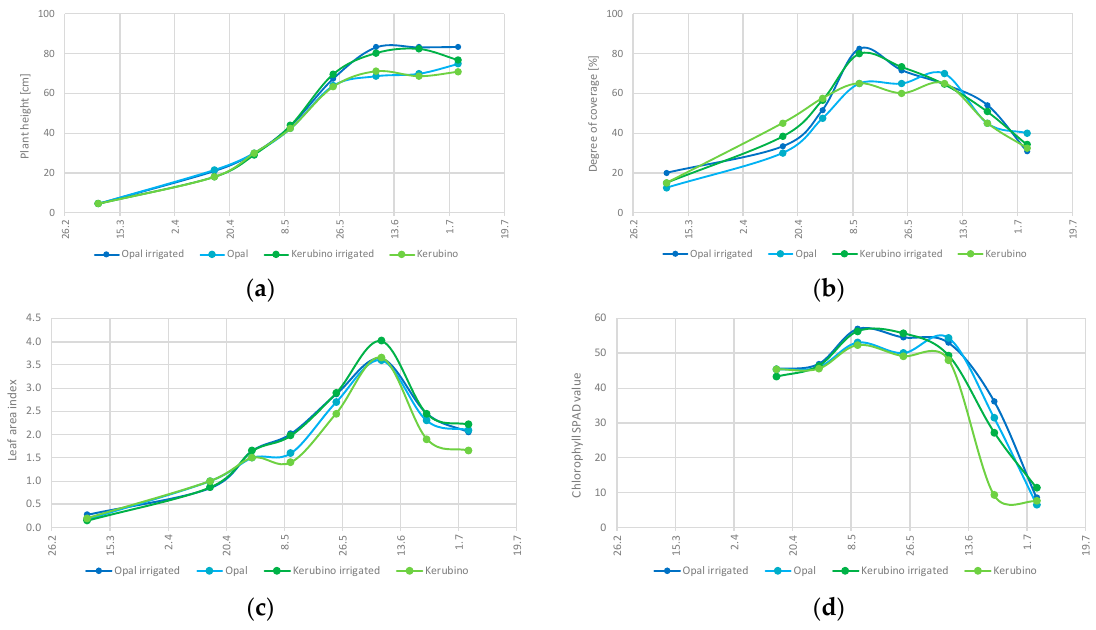
Figure 8. Measurements of the biometric parameters of the winter wheat varieties Opal and Kerubino on irrigated and unirrigated plots from March to July 2016; ( a ) plant height; ( b ) degree of coverage; ( c ) leaf area index; ( d ) chlorophyll SPAD value.